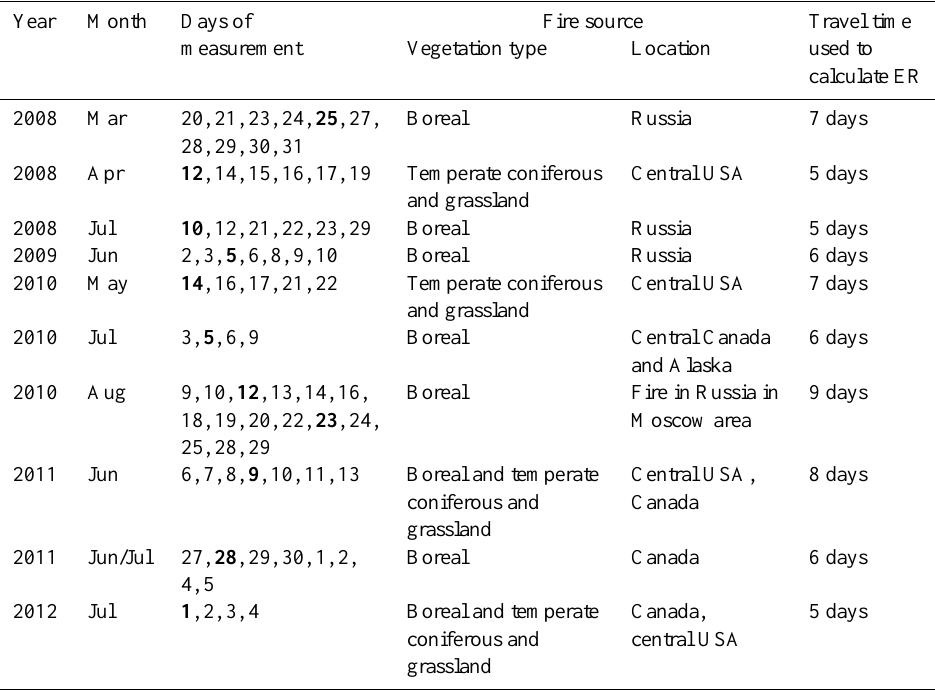
Table 1. Fire events detected over Eureka with the date, days of measurements, vegetation type burned, fire source location, and travel time to the day of peak enhancement (represented in bold in the third column) used to calculate emission ratios.